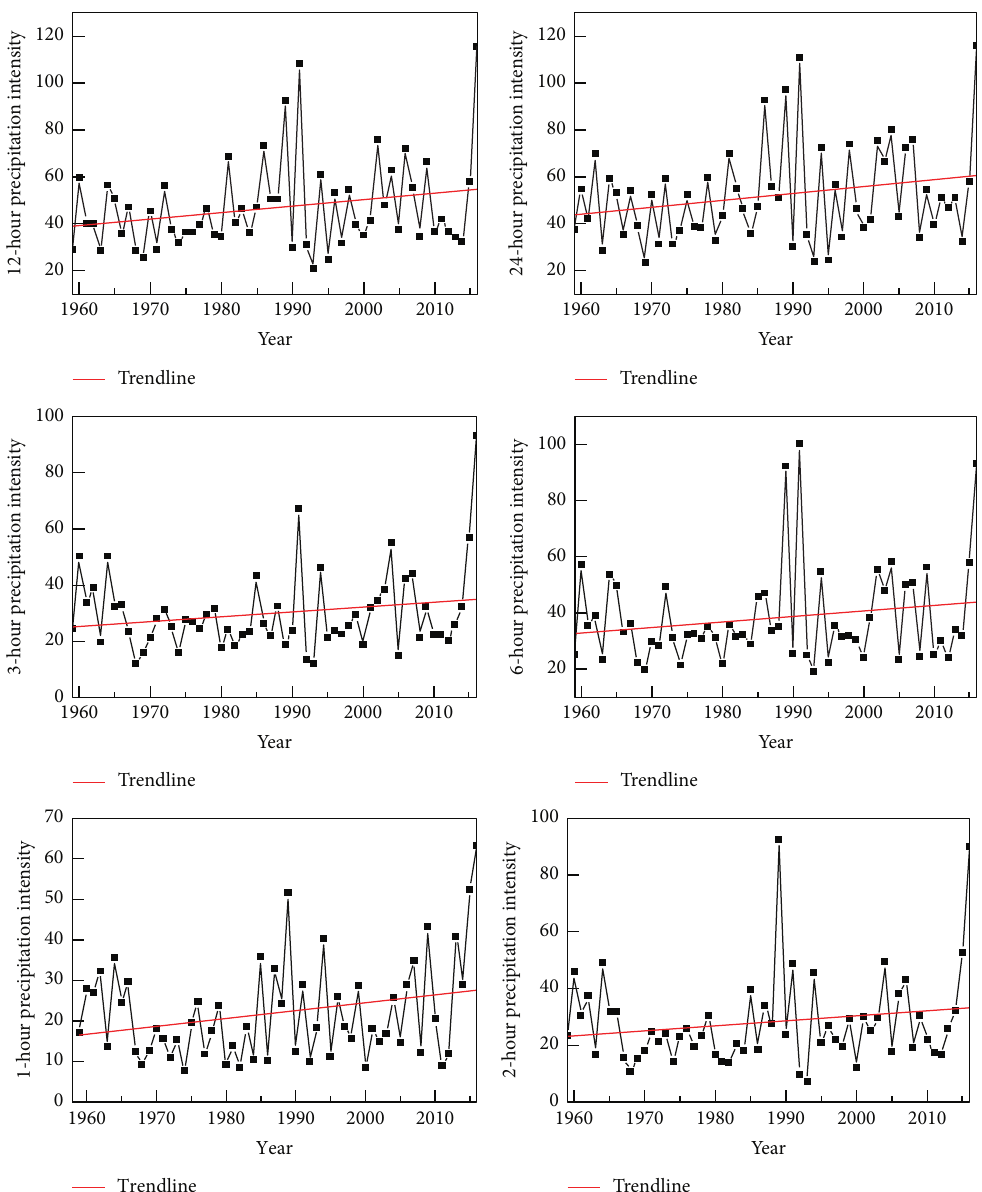
Figure 4: Trends of intensities of extreme precipitation with different